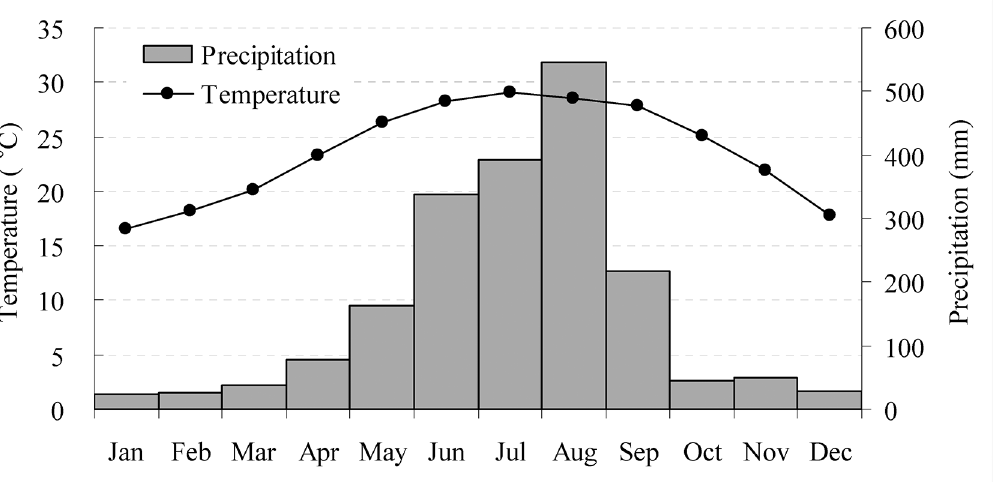
Fig 2. Generalized trends of the average monthly temperature (curve) and precipitation (bars) of the study site for the years 2006 to